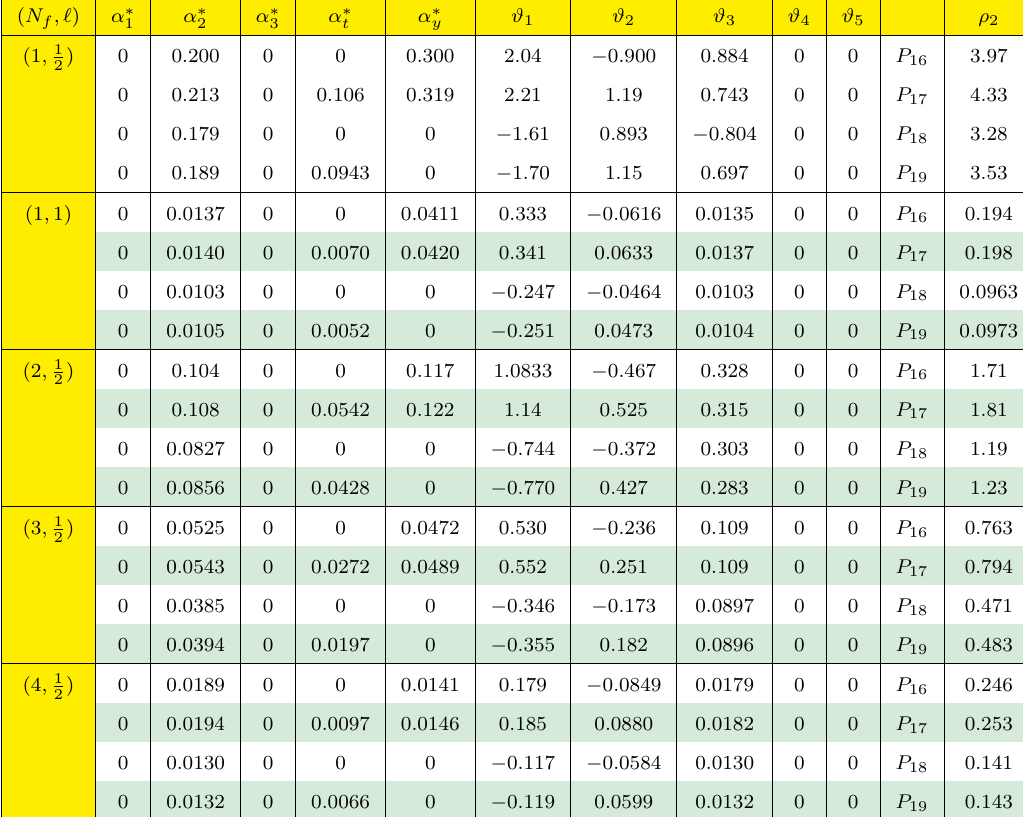
Table 3 . Set of (cid:12)xed points and eigenvalues for colorless vector-like fermions in the 210 approxi- mation scheme. We highlight in green the (cid:12)xed points that appear also in the 321 approximation. The labels in the second to the last last column refer to the list in table 12. We show in the last column the ratio (cid:26) de(cid:12)ned in eq. (2.14) knowing that in 210 A (2) (cid:3) = B (2) (cid:3) 2